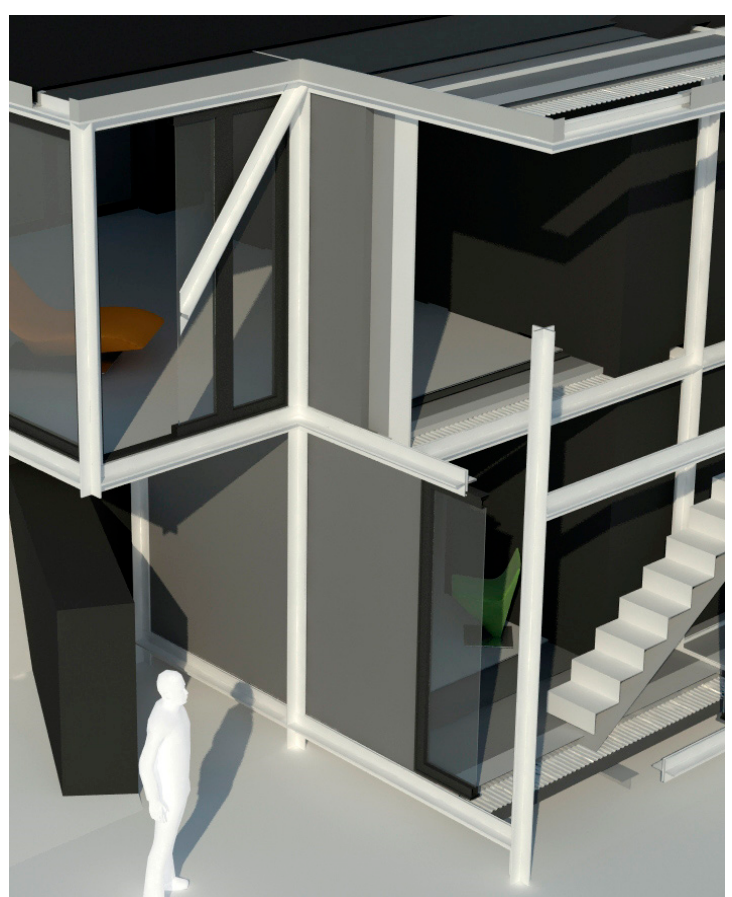
Figure 8. Three-dimensional image of the prototype, with the layers of materials on the walls, floors, and roof [2].